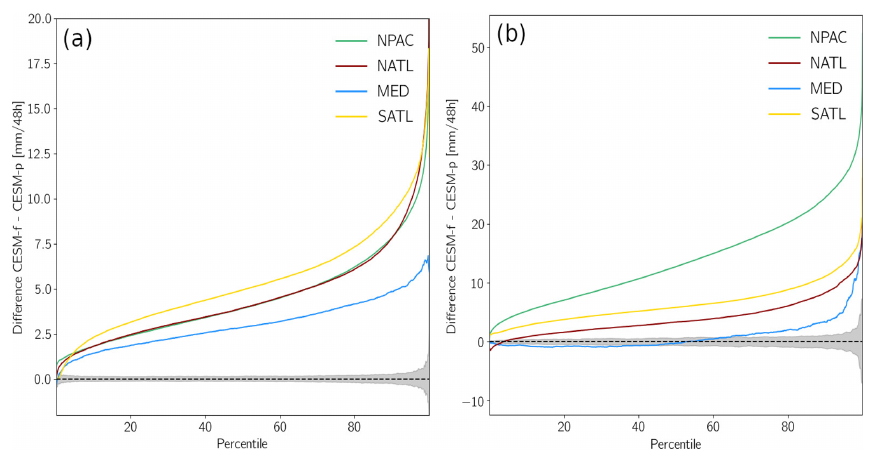
Figure 10. Difference in precipitation percentiles for the four target regions, in (a) winter and (b) summer. The grey-shaded area corresponds to the 95% confidence interval under the null hypothesis that the two precipitation distributions for HIST and RCP8.5 do not differ. This confidence interval is only shown for MED; for the other regions it falls within the one for MED. The confidence interval is calculated based on a resampling approach (see text for details). Note the different vertical axis scales in the two